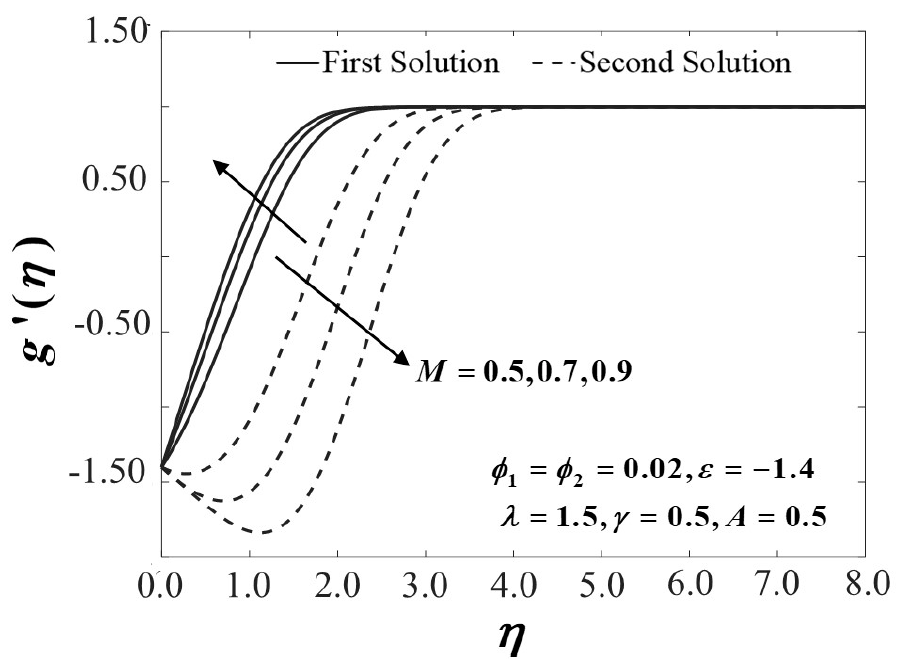
η′ for different values of M .